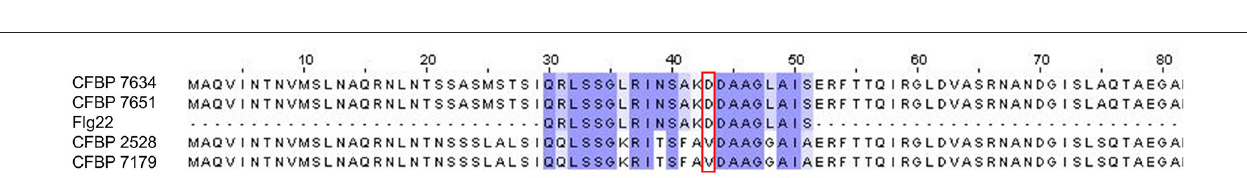
FIGURE 7 | Motility of the four X. arboricola strains. (A) CFBP 2528; (B) CFBP 7179; (C) CFBP 7651; (D) CFBP 7634, 60h after inoculation in TSA 10% (upper line) or MOKA (lower line), with agar 0.2%.